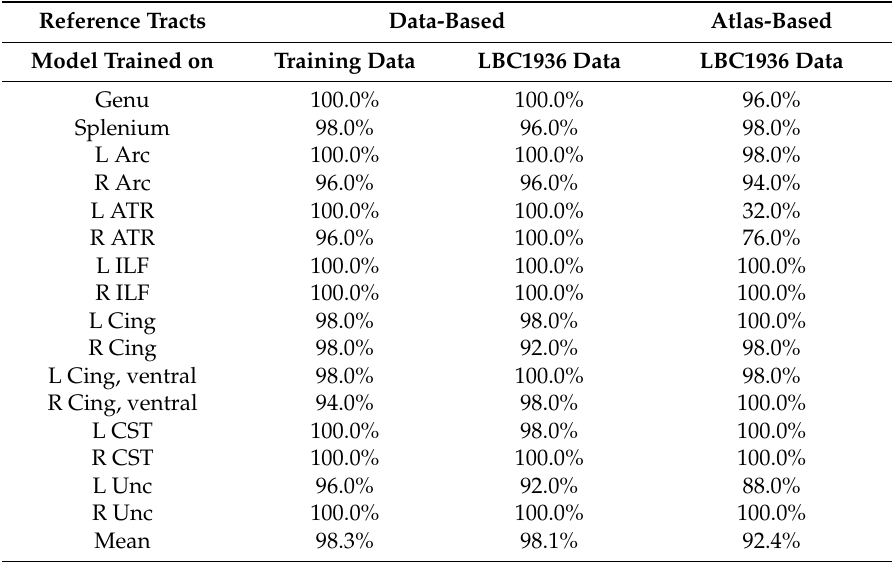
Table 1. Proportion of segmented tracts visually acceptable when using two different matching models and each set of reference tracts as priors. Reference